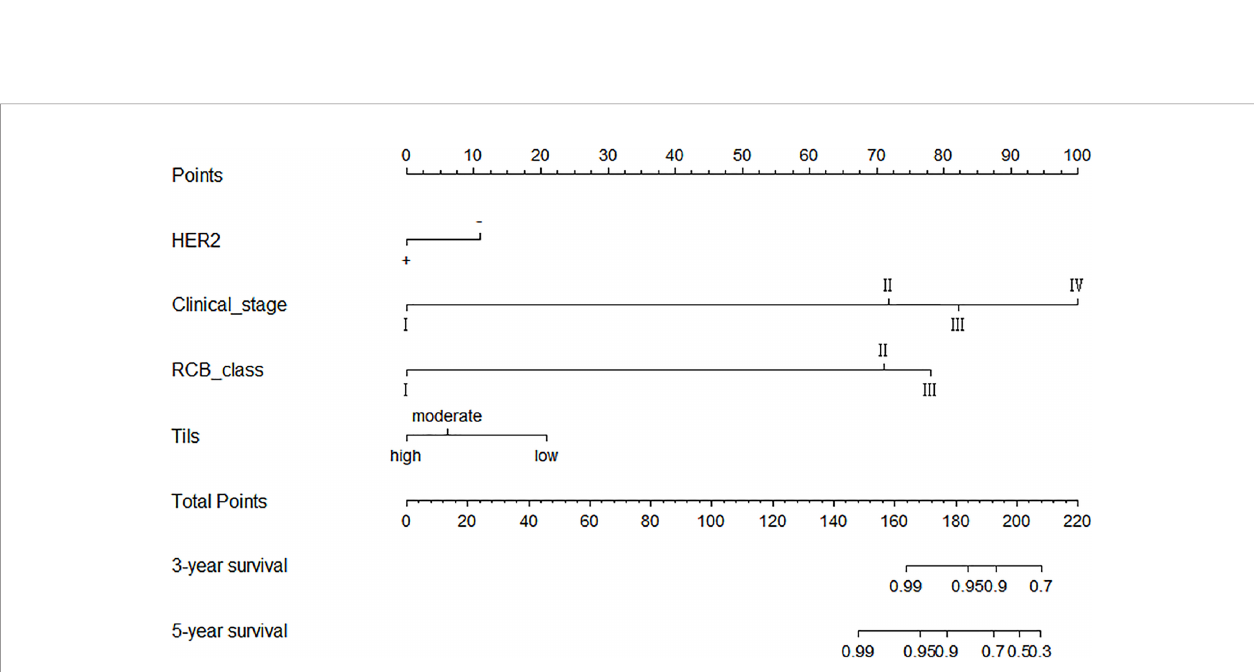
FIGURE 3 | Schematic diagram of prediction model. Each factor corresponded to one point, the scores of the four factors were summed to give a total score, and fi nally the corresponding 3-year and 5-year survival rates were calculated by using the R